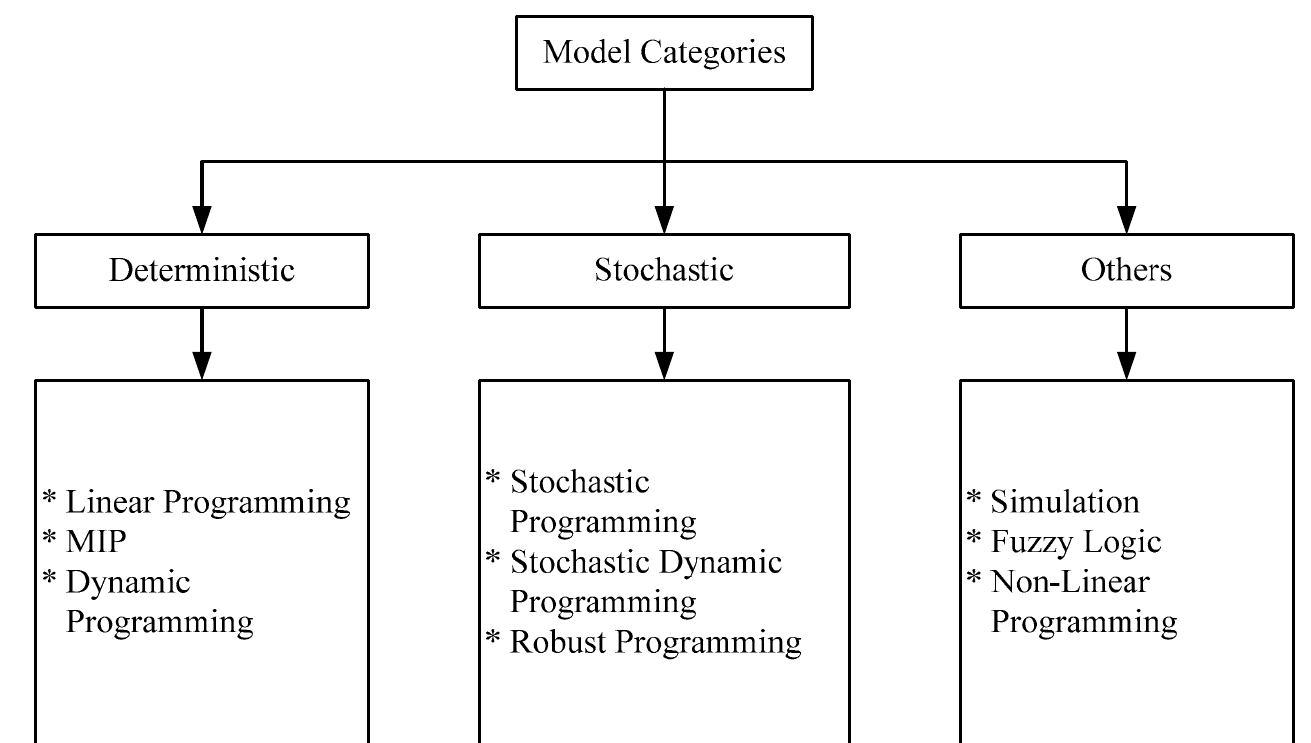
Figure 2. Model classification framework for fresh fruit supply chains.